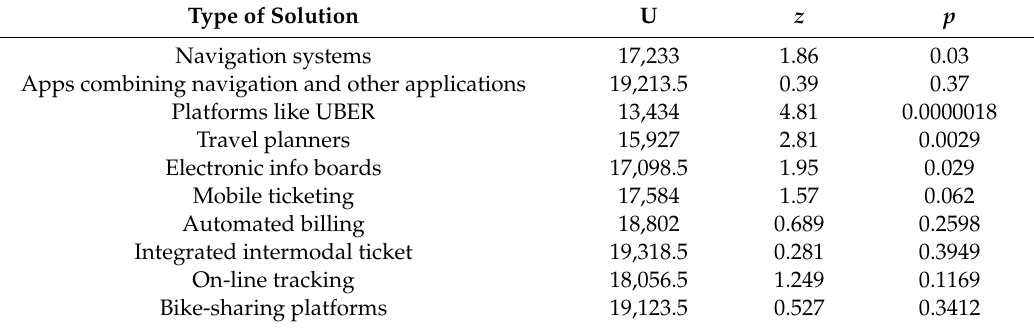
Table 4. Results of Mann–Whitney U-test comparing agglomeration and out of agglomeration users. Type of Solution